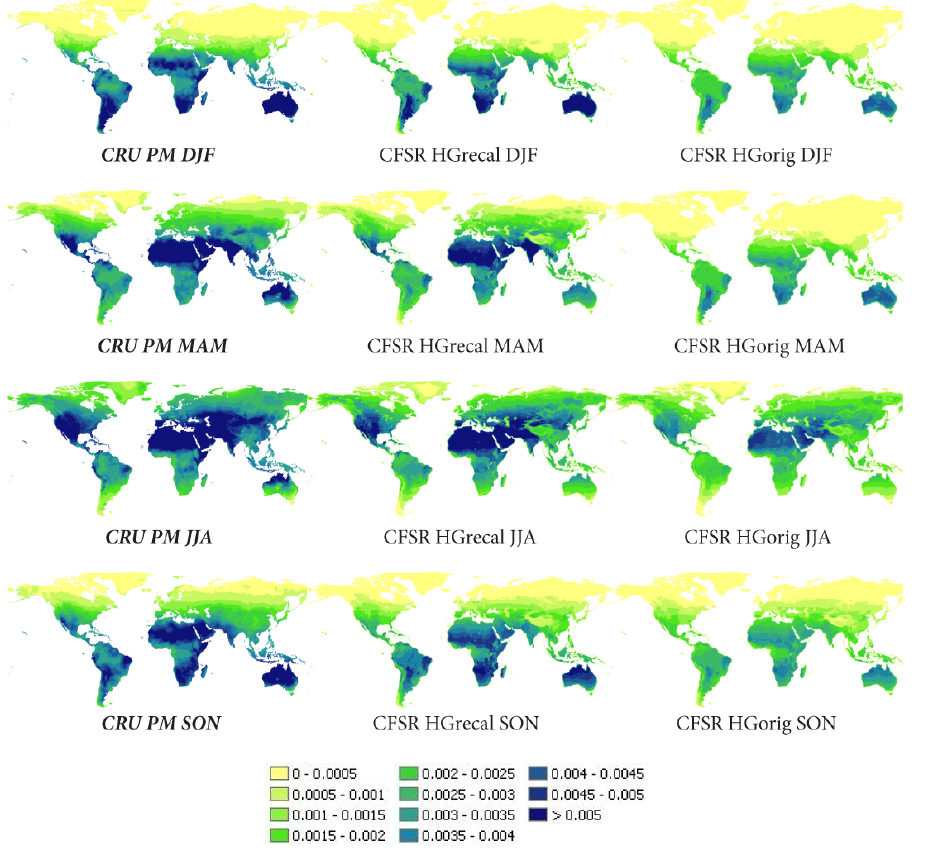
Fig. 4c. Global maps with seasonal average daily potential evaporation (mday − 1 ) . CRU derived with the Penman-Monteith equation (left; =reference for validation), CFSR derived with the re-calibrated Hargreaves equation (middle; HGrecal) and CFSR derived with the original Blaney-Criddle equation (right; HGorig). From top to bottom the DJF, MAM, JJA and SON